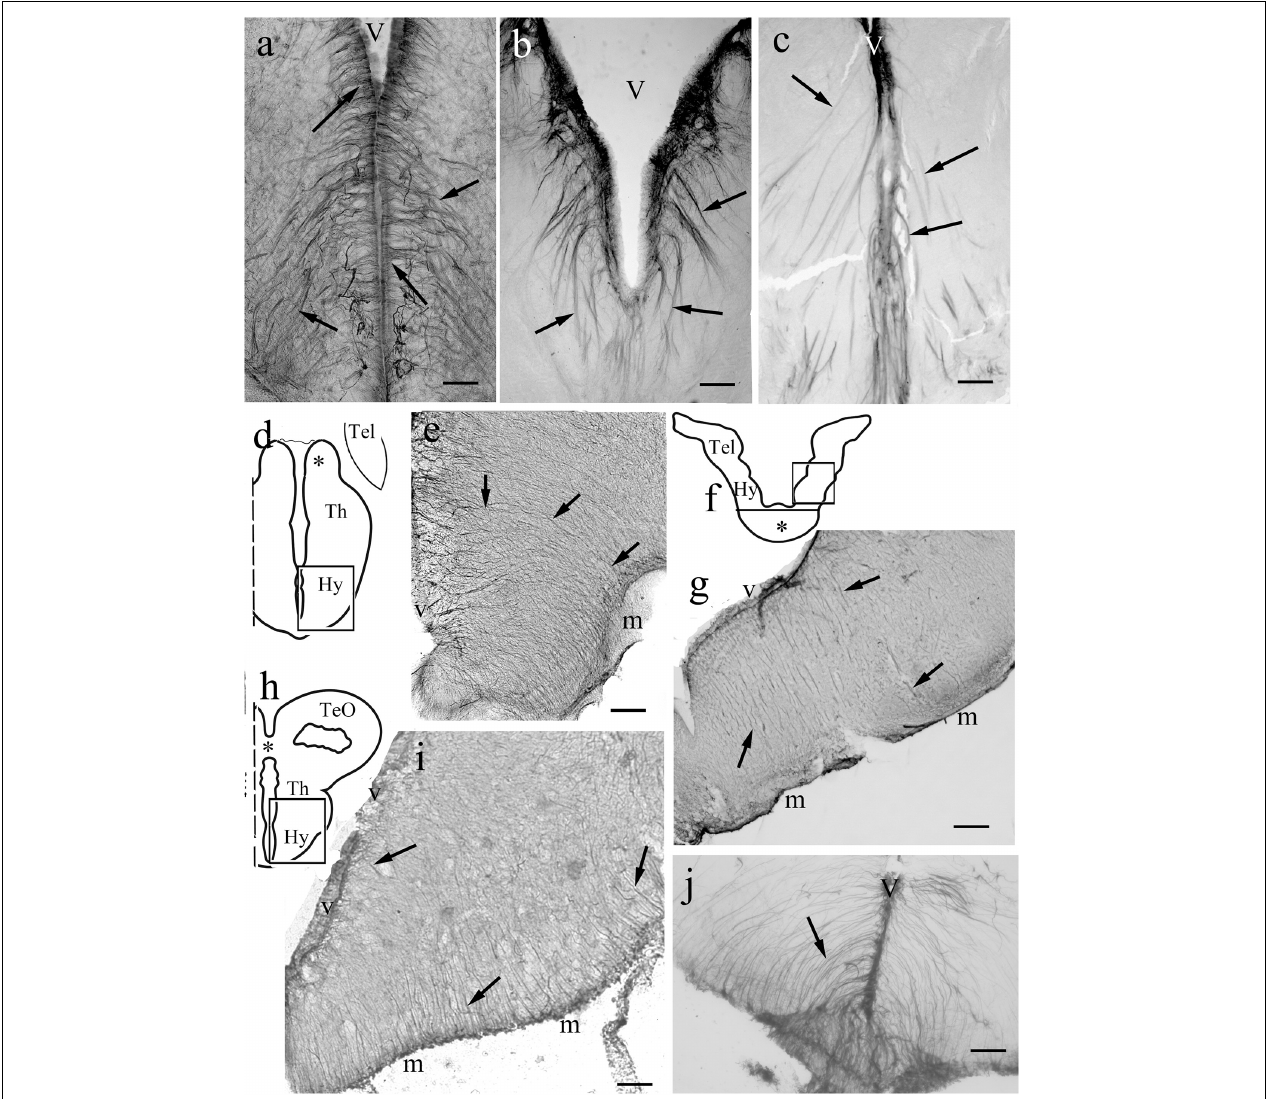
FIGURE 6 | Diencephalon. (a–c) The diencephalic ventricle (V) in eel, carp, and sander. Note the oblique thick processes (arrows). In eel and carp the ependymal origin is recognizable well. Scale bars: 200 µ m. (d) Sketch of bichir diencephalon redrawn after López et al. (2013) with the position of panel (e) . Hy, Th: hypothalamus, thalamus, Tel: posterior end of telencephalon; asterisk: habenula, wavy line: the thin roof of ventricle (e) Bichir hypothalamus, caudal part, penetrated with arcuate processes (arrows). m, v: meningeal and ventricular surfaces. Scale bar: 100 µ m. (f) Sketch of sterlet prosencephalon redrawn after Rupp and Northcutt (1998) with the position of panel (g) . Hy: hypothalamus, Tel: telencephalon, line and asterisk: optic chiasm. The roof of the ventricle is not shown. (g) Sterlet hypothalamus, m, v: meningeal and ventricular surfaces, arrows: radial glia. Scale bar: 100 µ m. (h) Sketch of gar diencephalon at the posterior commissure (asterisk) redrawn after Parent and Northcutt (1982), with the position of panel (i) . Hy, Th: hypothalamus, thalamus. TeO: optic tectum. (i) Gar hypothalamus. m,v: meningeal and ventricular surfaces, arrows: astroglial processes. Scale bar: 100 µ m. (j) Eel, median eminence. Arrow: arched glial processes. Scale bar: 80 µ m.